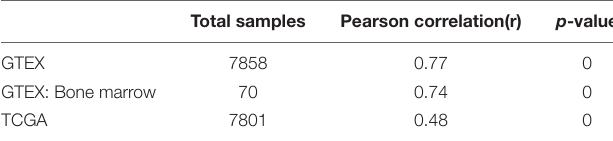
TABLE 2 | The co-expression of ASPH with CTNNB1